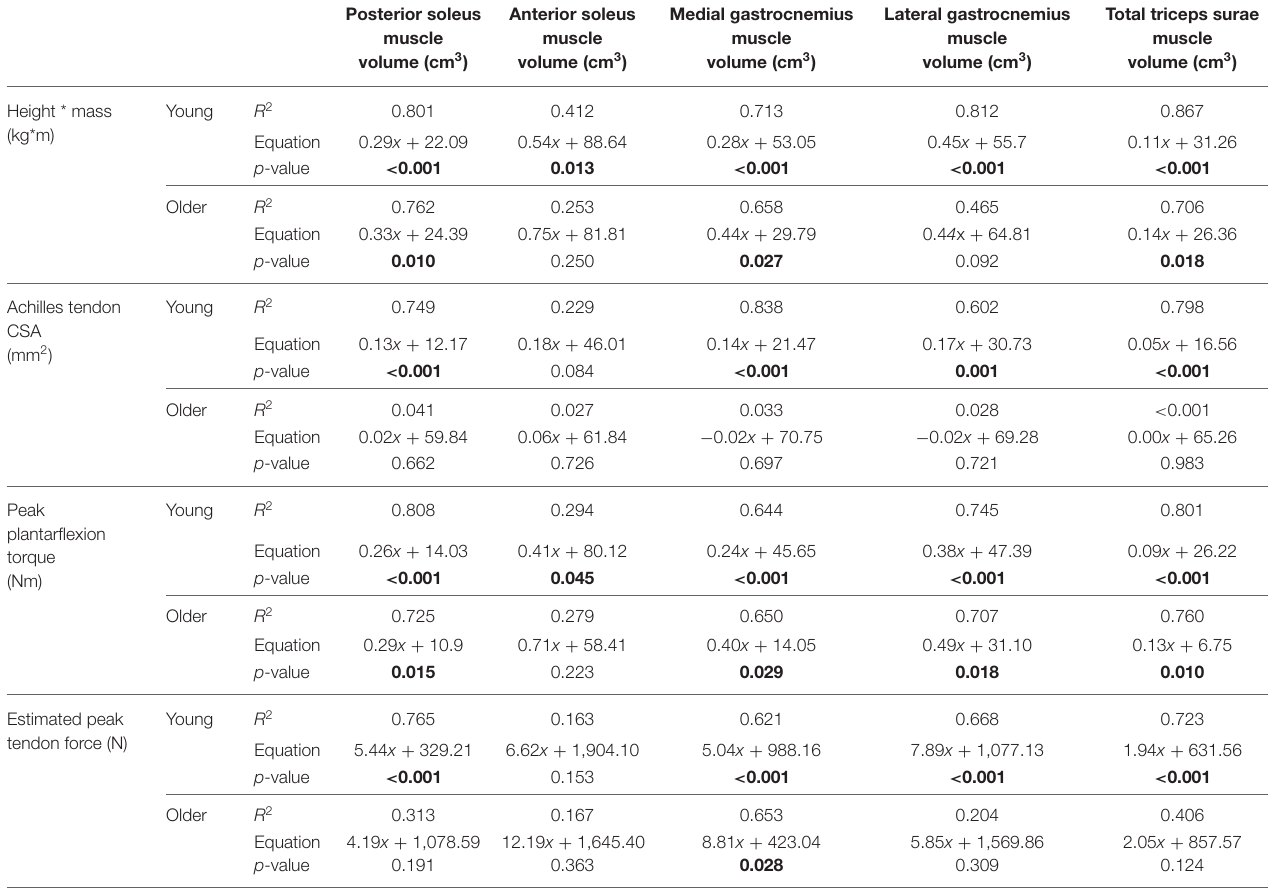
TABLE 3 | Linear regression was used to determine the relationship between individual and total muscle volumes and body size, calculated as height * mass; Achilles tendon CSA; peak plantarflexion torque during walking at 1.25 m/s; and peak Achilles tendon force, estimated by dividing peak torque by moment arm, in young and older